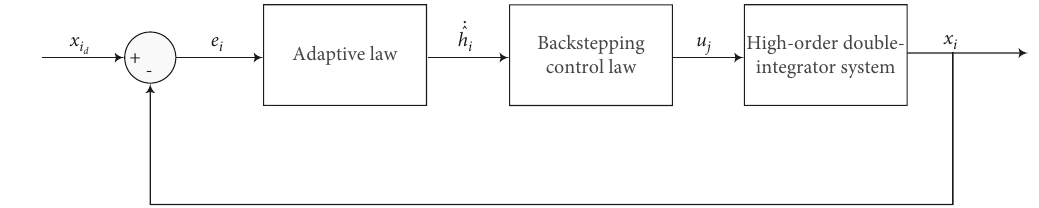
Figure 1: Block diagram of the proposed